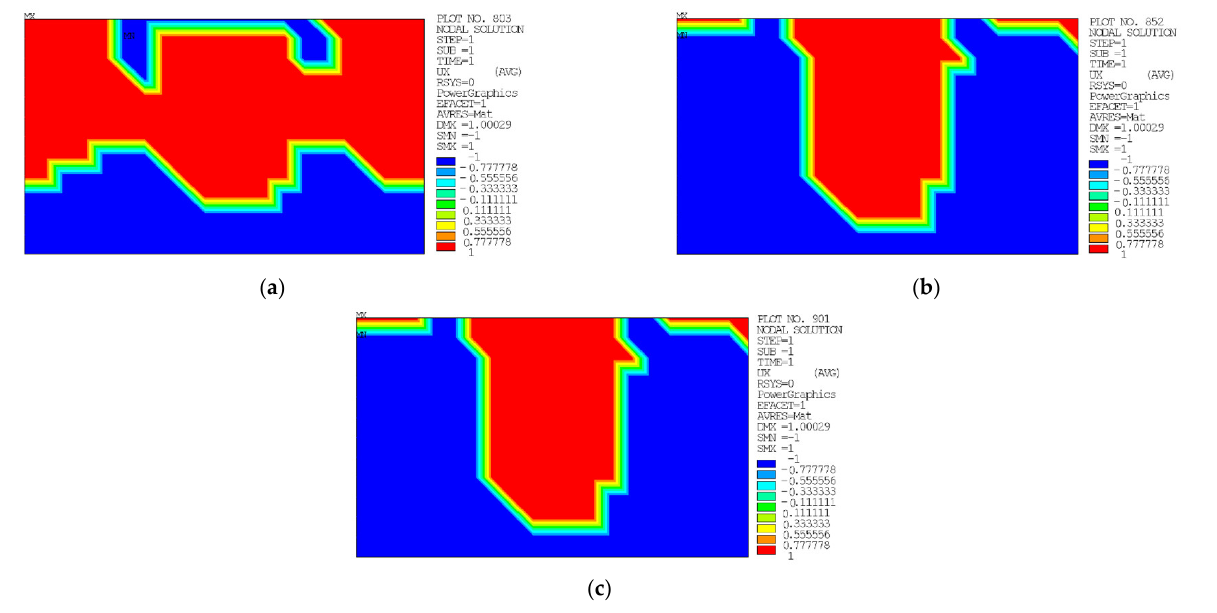
Figure 12. FEs in the plastic behavior state and their evolution to elastic behavior at ( a ) 4.385; ( b ) 434.115 and ( c ) 872.615